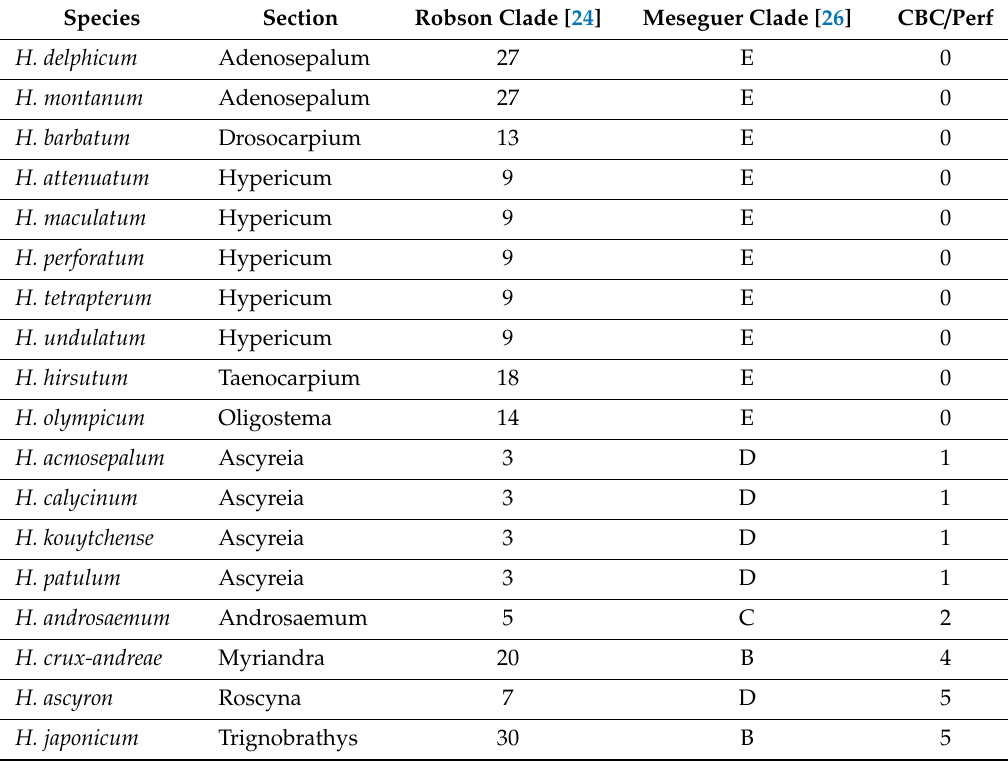
Table 2. Complementary base pair changes (CBC) in ITS2 RNA secondary structures, relative to the H. perforatum ITS2 secondary structure, calculated using the 4Sale program [48,51].